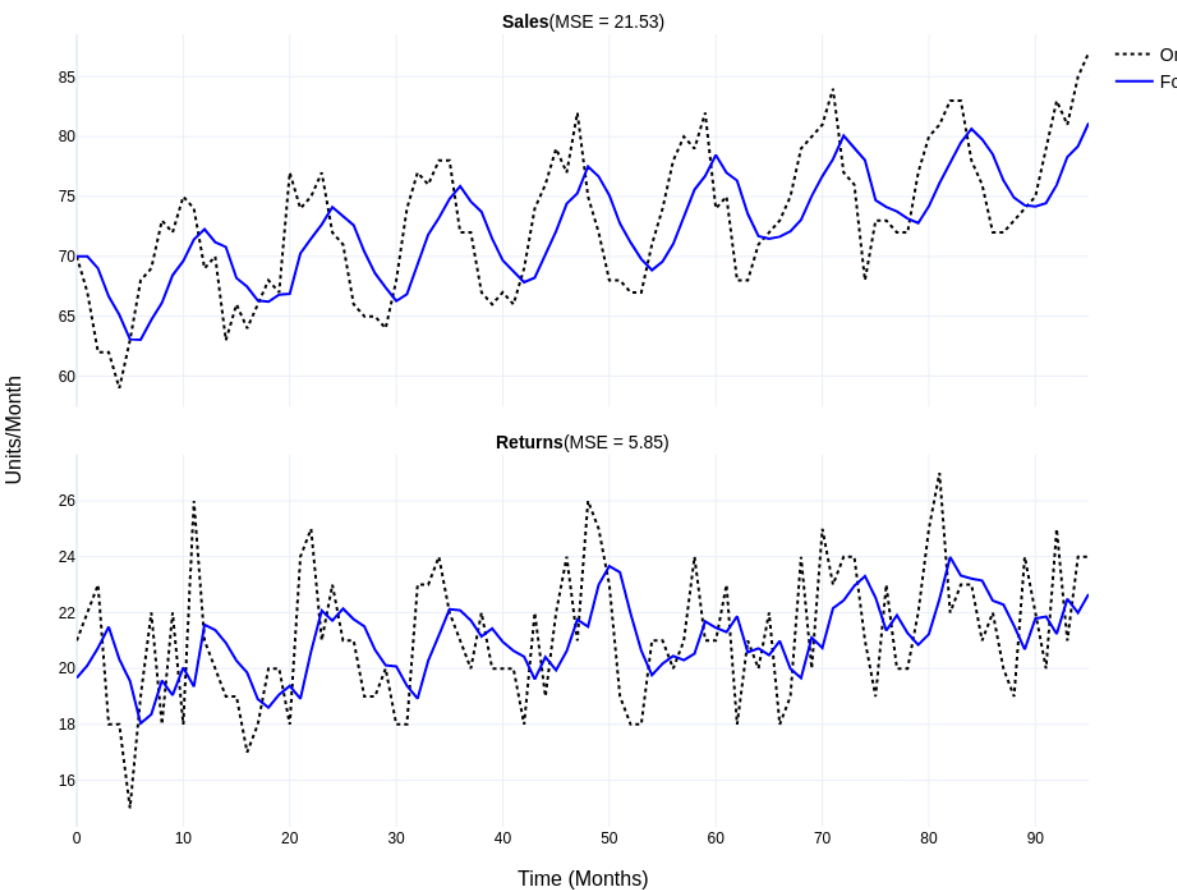
Figure 9. An exponential smoothing approach to forecasting sales and returns.